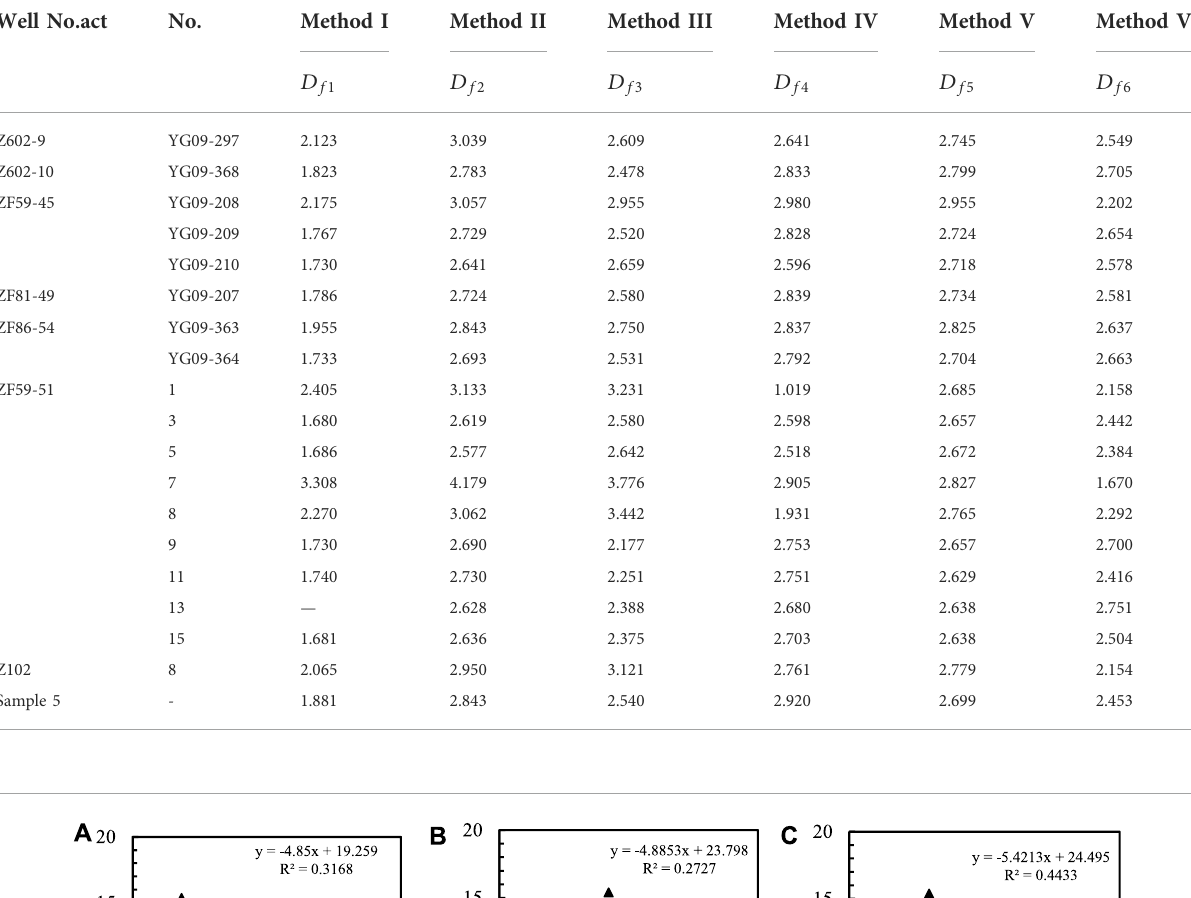
TABLE 2 Fractal dimension values calculated by different models. Well No.act